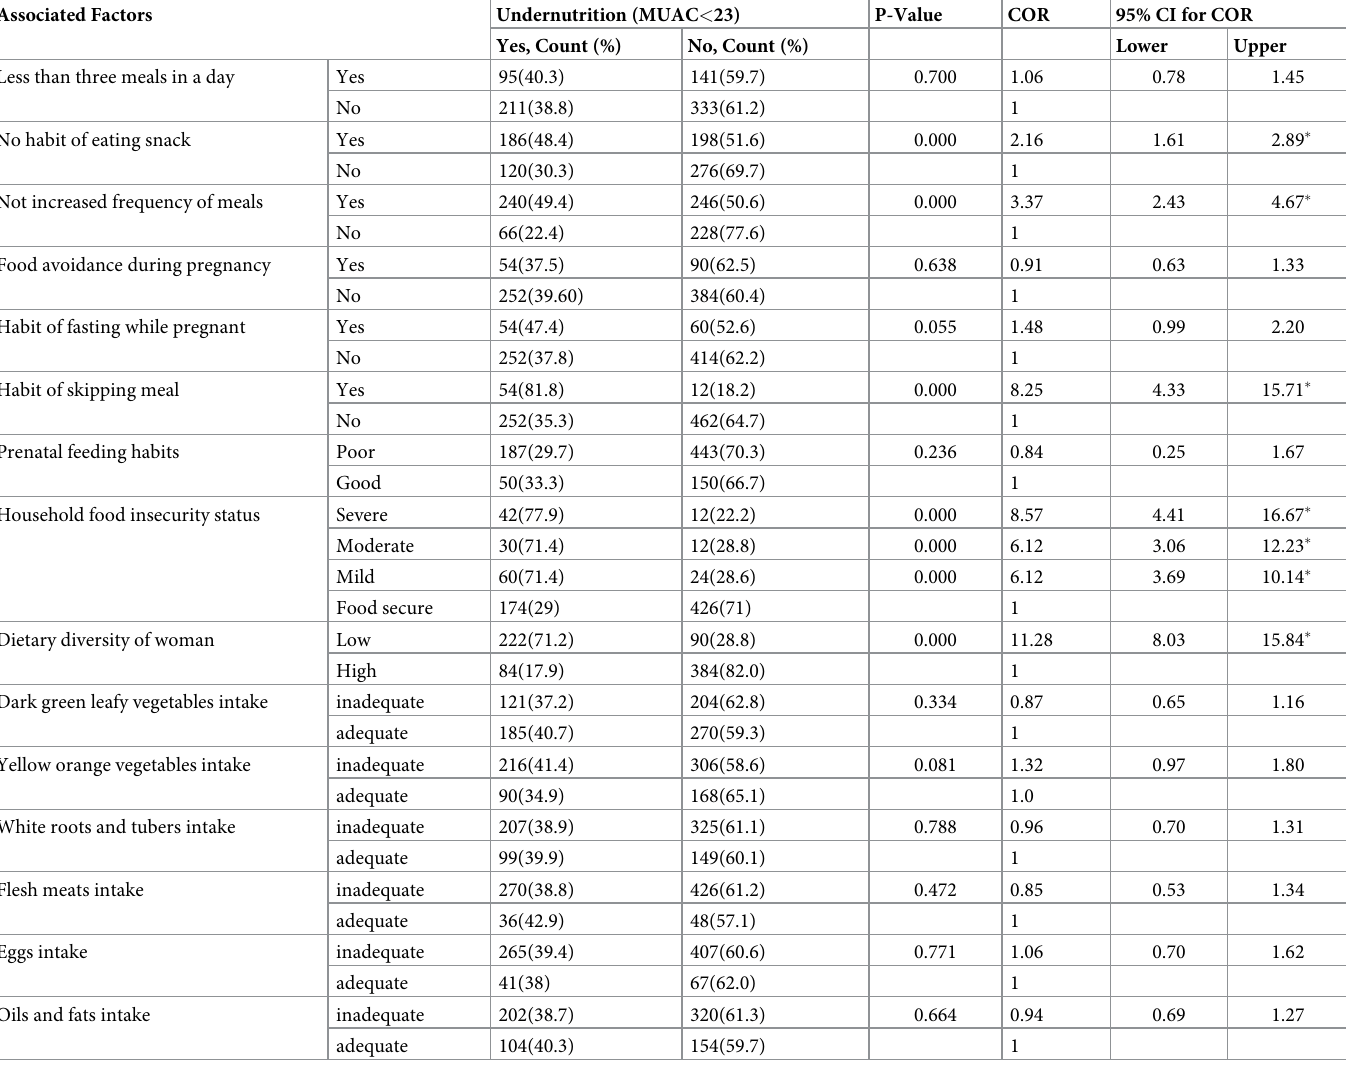
Table 7. Bivariate analysis of dietary factors with nutritional status of pregnant women attending antenatal care clinics in public hospitals of West Wollega Zone, 2020. Associated Factors